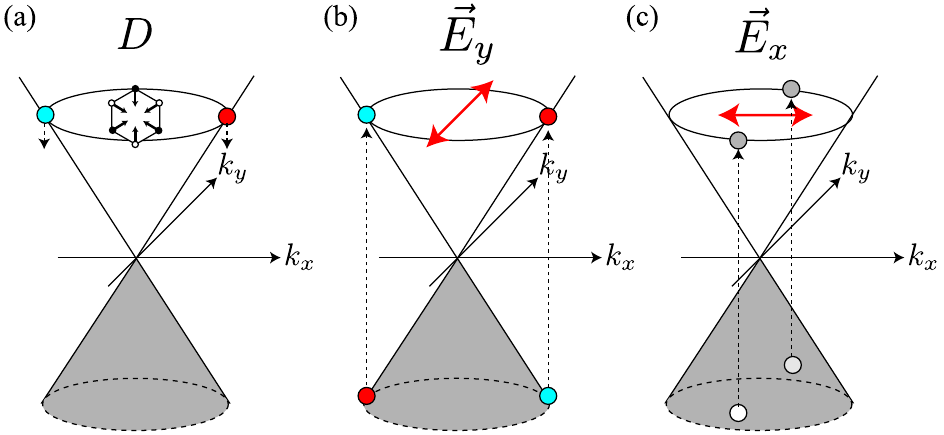
Figure 4. Light polarization dependence of the D band. ( a ) An A through a first-order process from the electrons with bonding and antibonding orbitals on the k -axis; ( b ) To supply a photo-excited electron to the states on the k x light polarization must be parallel to the y -axis or the armchair edge; ( c ) ⃗ E photo-excited electron at the k -axis. Such an electron changes its position when it emits an y A mode, and thus it cannot contribute to the D 1 g